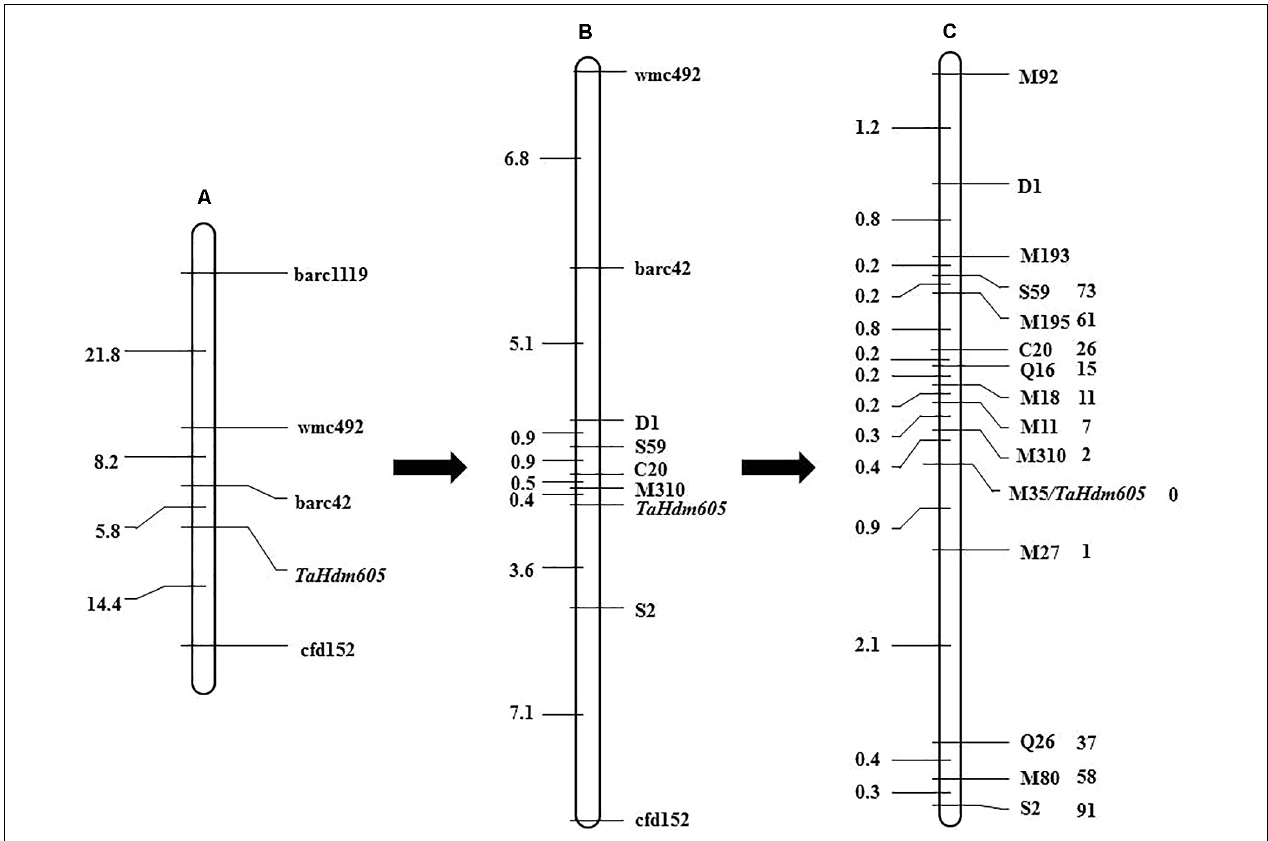
FIGURE 2 | Genetic map of the heading date gene TaHdm605 . (A) Initial mapping of the heading date gene TaHdm605 obtained with public markers and 120 F 2 plants. (B) Genetic mapping of the heading date gene TaHdm605 obtained with markers developed by using the A. tauschii genome sequence (Ver. 0.1). (C) High-resolution genetic map of TaHdm605. The genetic distances in cM are shown on the left, and the markers are shown on the right. The numbers on the right of the markers represent the recombinants of the corresponding